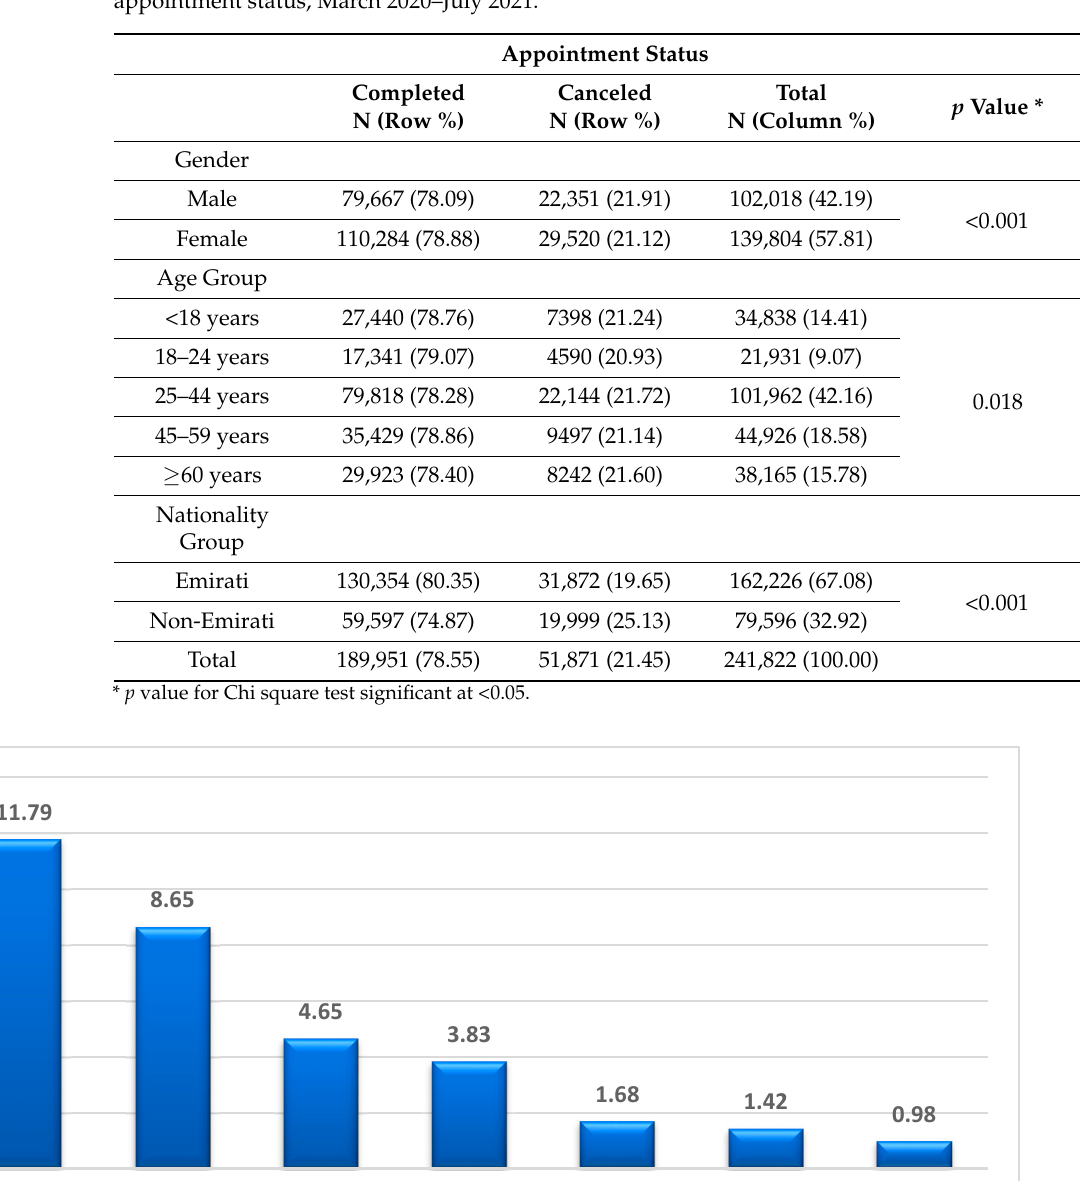
Table 1. Demographic characteristics of patients who scheduled a telehealth visit at DHA, by